Question: Give a one-sentence summary of this figure.
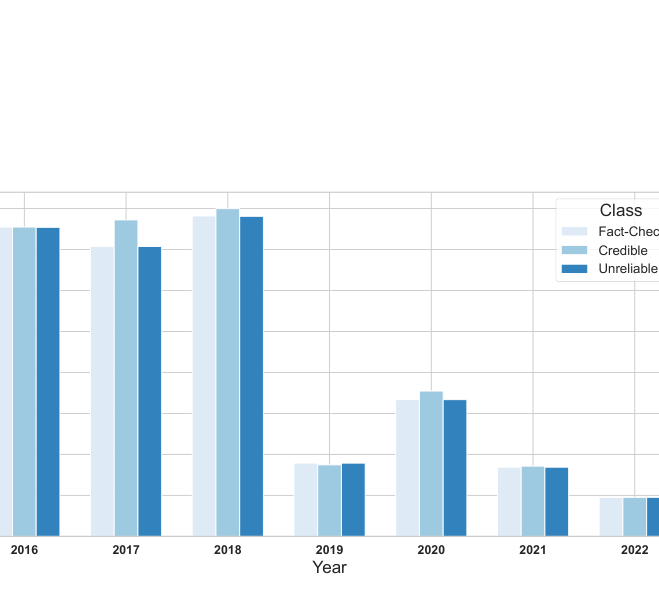
Answer: Number of articles per year in CREDULE.